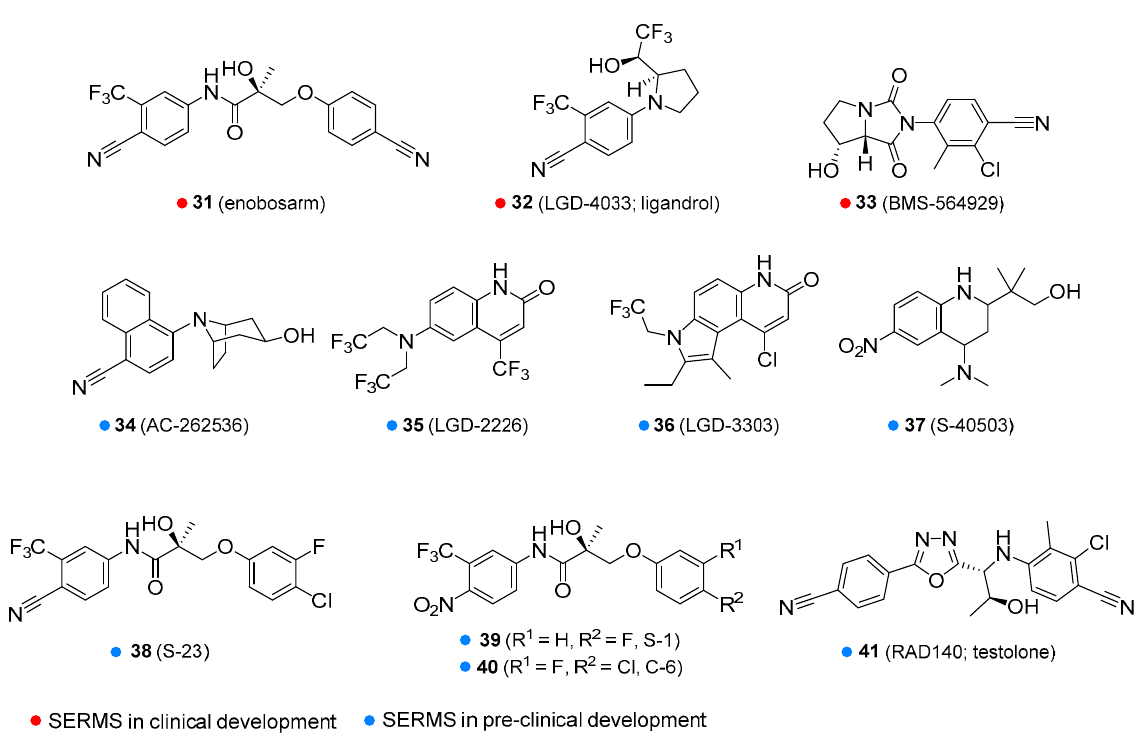
Figure 7. Some of the selective androgen receptors modulators in clinical or pre-clinical development.